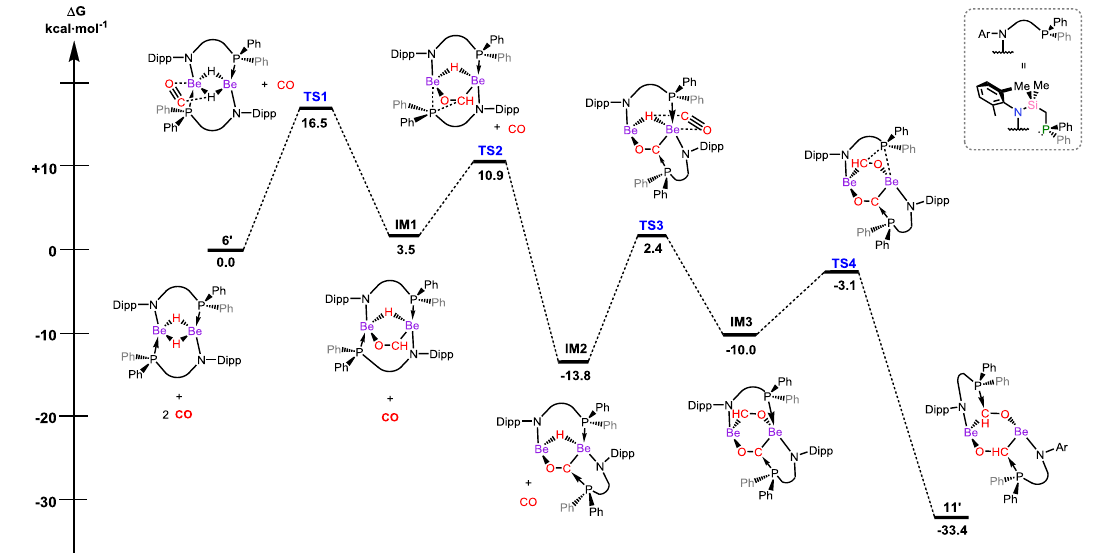
Fig. 5 Calculated free energy pro fi le for the reaction of 11 ′ with two equivalents of CO. The reaction proceeds via two consecutive CO insertion events, each beginning through side-on approach of the CO molecule to the Be – H moiety, and concluded by P-migration from Be to the terminal